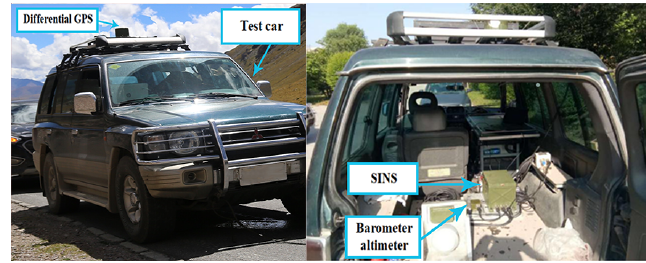
Figure 15. Experimental car and equipment.